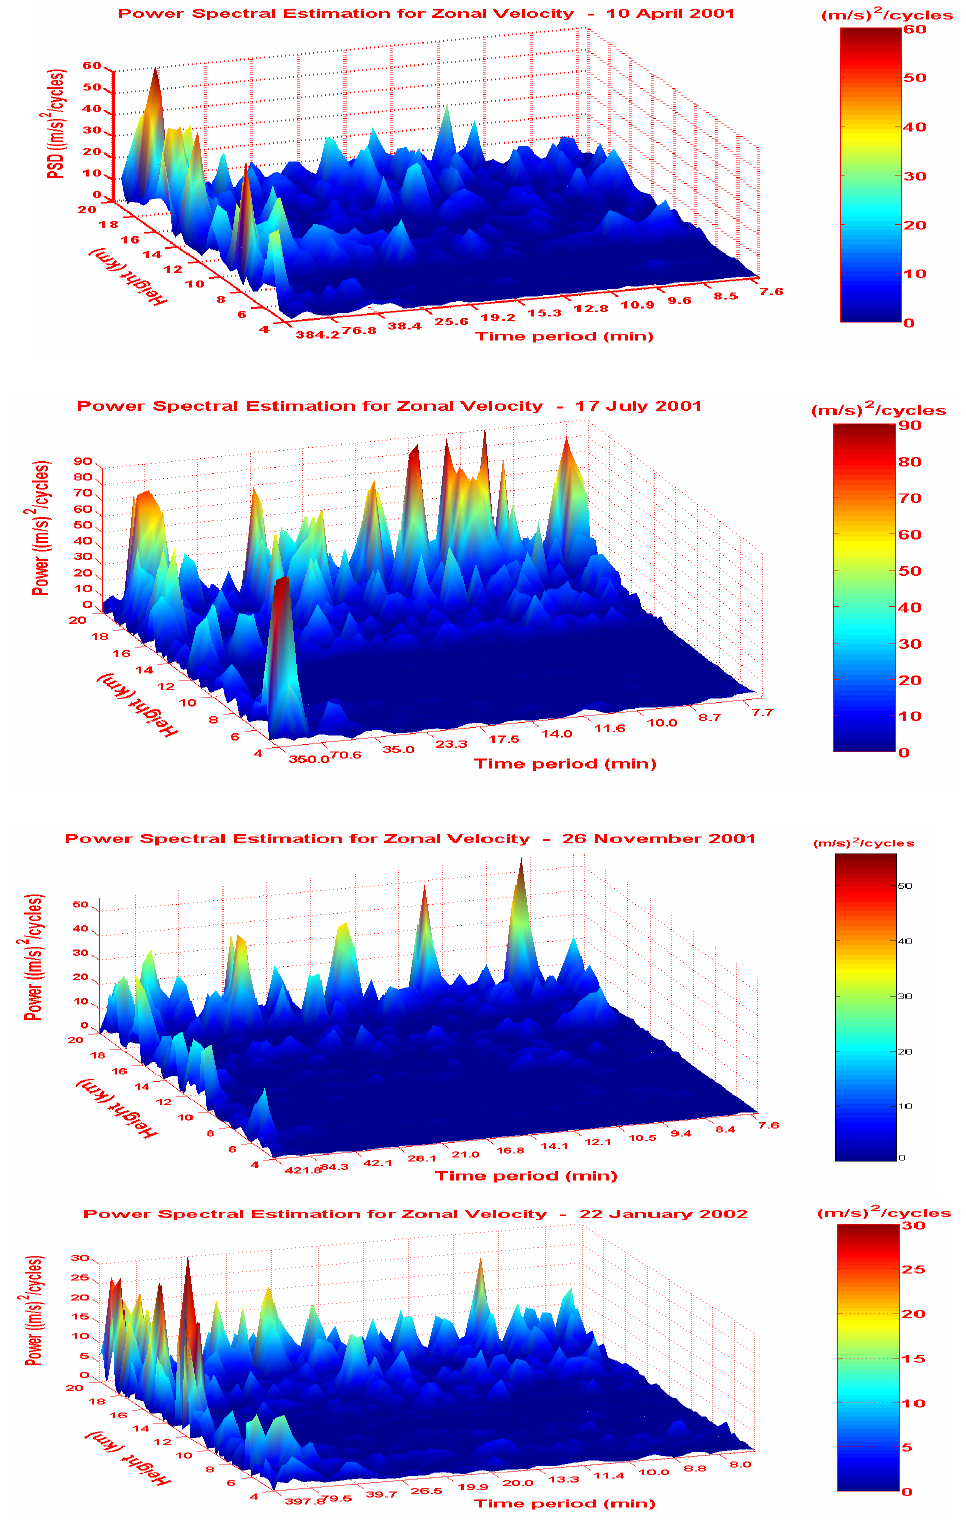
Fig. 8. Fig. 8. Frequency-power spectral estimation for zonal velocity fluctuations as a function of height for a typical day, observed 6h with Indian MST Radar during 10 April 2001, 17 July 2001, 26 November 2001 and 22 January